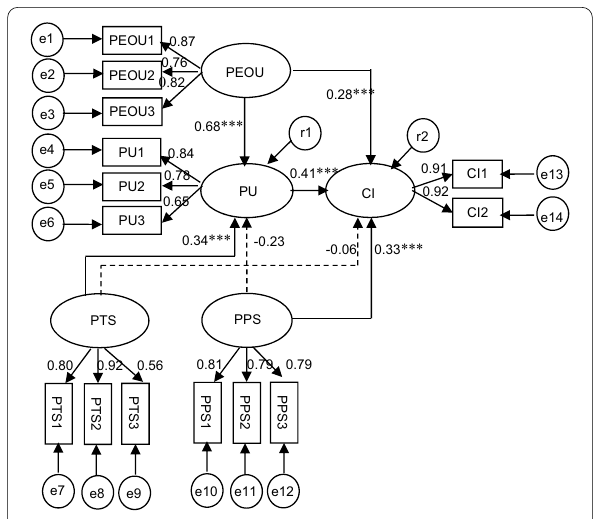
Fig. 3 Structural model results. Note :***suggests that correlation is significant at the 0.01 level